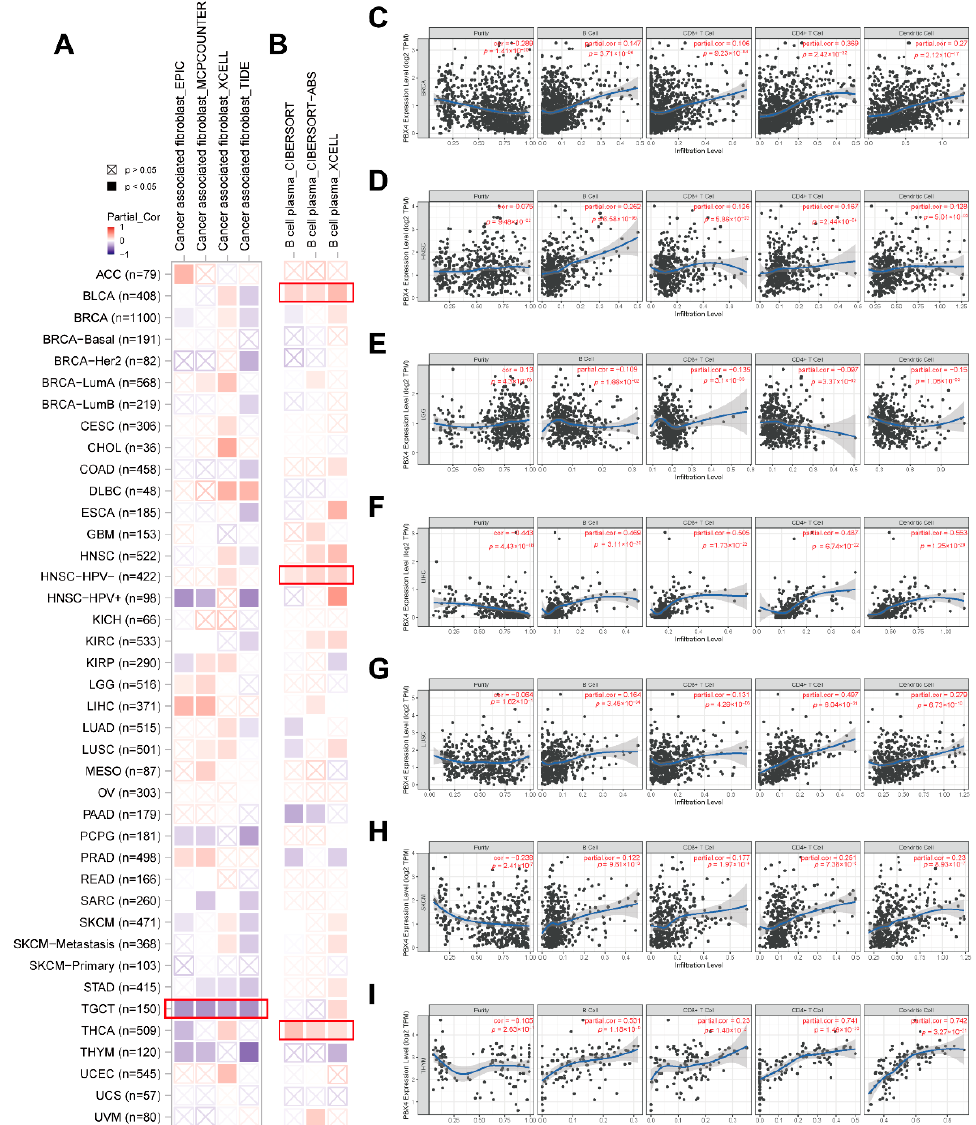
Figure 11. Correlation of PBX4 expression with immune infiltration levels across TCGA cancers. ( A ) Association between PBX4 expression and cancer associated fibroblasts and ( B ) B-cell plasma in different TCGA cancers. Association between PBX4 expression and B cells, CD8+ T cells, CD4+ T cells, and dendritic cells in ( C ) BRCA, ( D ) HNSC, ( E ) LGG, ( F ) LIHC, ( G ) LUSC, ( H ) SKCM, and ( I ) THYM.